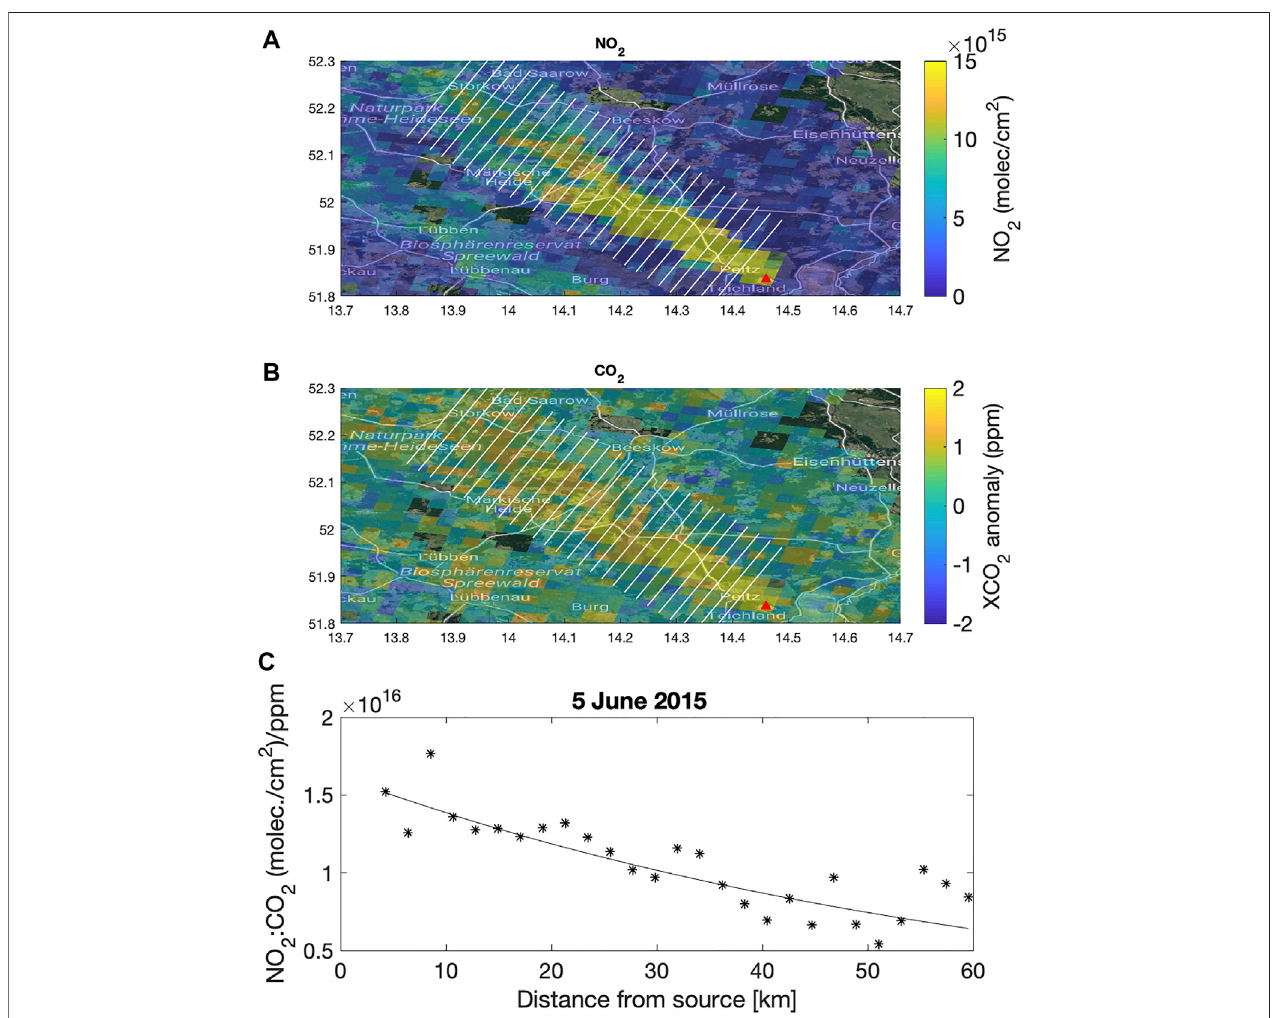
FIGURE 7 | Example of the calculation of source-speci fi c NO x -to-CO 2 emission ratio for Jänschwalde power station on 5 June 2015. Panel (A) and (B) show the NO 2 and CO 2 plumes. Panel (C) shows the cross-sectional NO 2 -to-CO 2 ratio calculated over several transects [white lines in panels (A) and (B) ], located at regular distance downwind from the source. Black symbols and line indicate the ratios and the corresponding exponential decay, respectively.